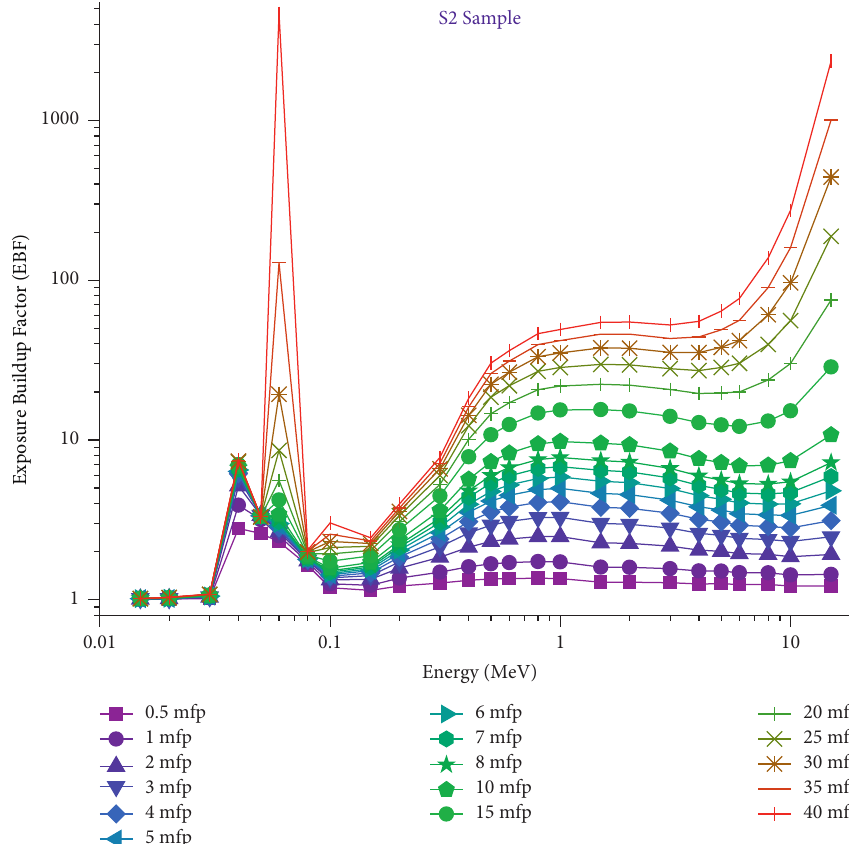
Figure 12: Demonstrates the relationship between the energy and EBF of the S2